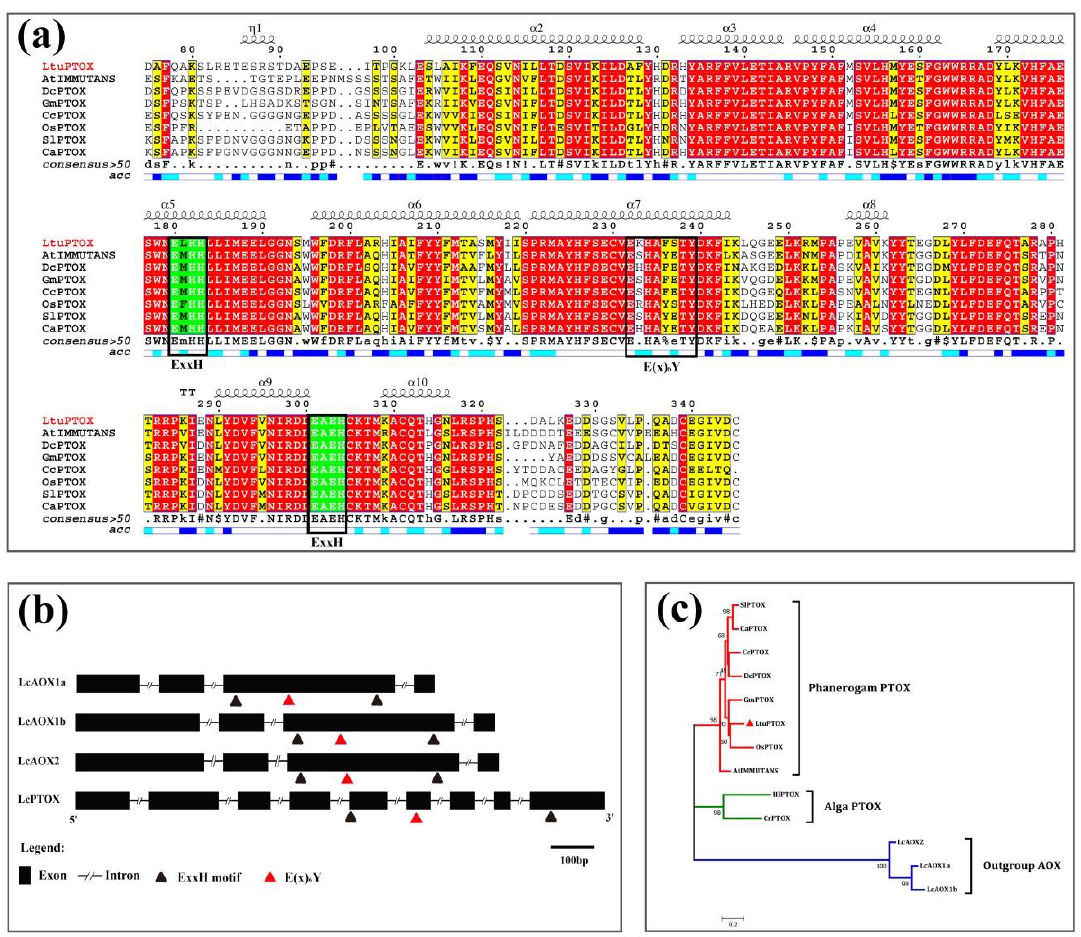
Figure 2. Sequence alignment and phylogenetic analysis of LtuPTOX ( a ), Multiple sequence alignment of PTOXs, where the helixes on top of the lines are α -helixes, blue and white bars indicate the site accessibility of the protein (blue bars represent the amino acids that are accessible, cyan bars represent those with intermediate accessibility, and white bars indicate those that are not accessible. ExxH modules with a green background are the putative di-iron coordination motifs, and the E(x) 6 Y module with black border is considered to be another active site [37]. (GenBank accessions: SlPTOX, NP 001234511.1; CaPTOX, AAG02288.1; CcPTOX, ABB70513.1; DcPTOX, AJE24555.1; GmPTOX, NP_001242139.2; LtuPTOX, MN368606; AtIMMUTANS, AJ004881; OsPTOX, AF085174). ( b ), Gene structure comparison of Liriodendron PTOX and AOXs, where rectangles represent exons, lines represent introns, and triangles represent di-iron coordination motifs. ( c ), Phylogenetic analysis based on PTOXs and the Liriodendron AOXs (LcAOX1a, MN187966; LcAOX1b, MN187968; and LcAOX2, MN187967; HlPTOX, ABF85789.1; CrPTOX, XP_001703466.1).